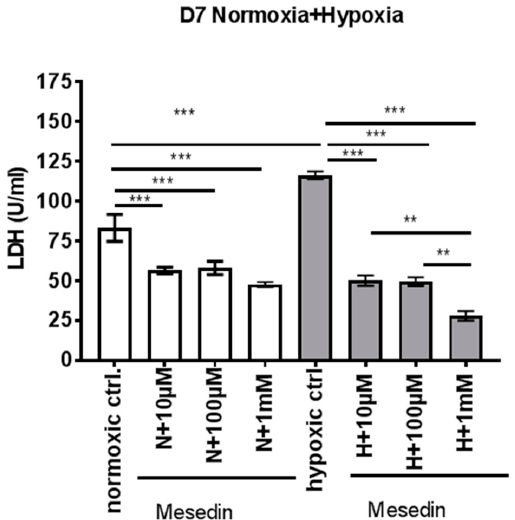
Figure 2. Lactate dehydrogenase (LDH) release from astroglial primary culture treated with mesedin upon normoxia and hypoxia. APC at day 7 in-vitro (DIV7) from newborn C57BL/6 mice ( n = 6) were incubated for 48 h with ascending concentrations (10 µM, 100 µM, and 1 mM) of mesedin under normoxic (N, white bars) and hypoxic (H, grey bars) culture conditions and compared to respective controls without mesedin (normoxic and hypoxic ctrl.). The data presented as mean ± SEM were analyzed with one-way ANOVA and Bonferroni’s comparison test, ** p < 0.01, *** p < 0.001. Upon both normoxia and hypoxia, LDH decrease was achieved by all three concentrations used, where the highest concentration (1 mM) was the most effective in the hypoxic condition (Figure 2). In our further experiments, we used the lowest concentration of mesedin (10 µM), which turned to be efficacious in decreasing LDH release under both normoxic and hypoxic conditions in APC.